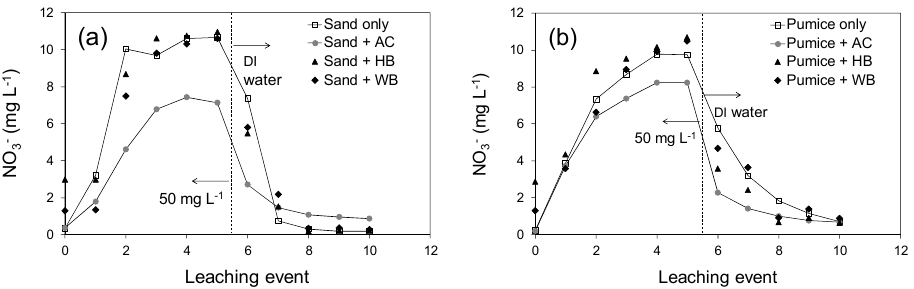
− ) in column effluents: ( a ) sand and ( b ) 3